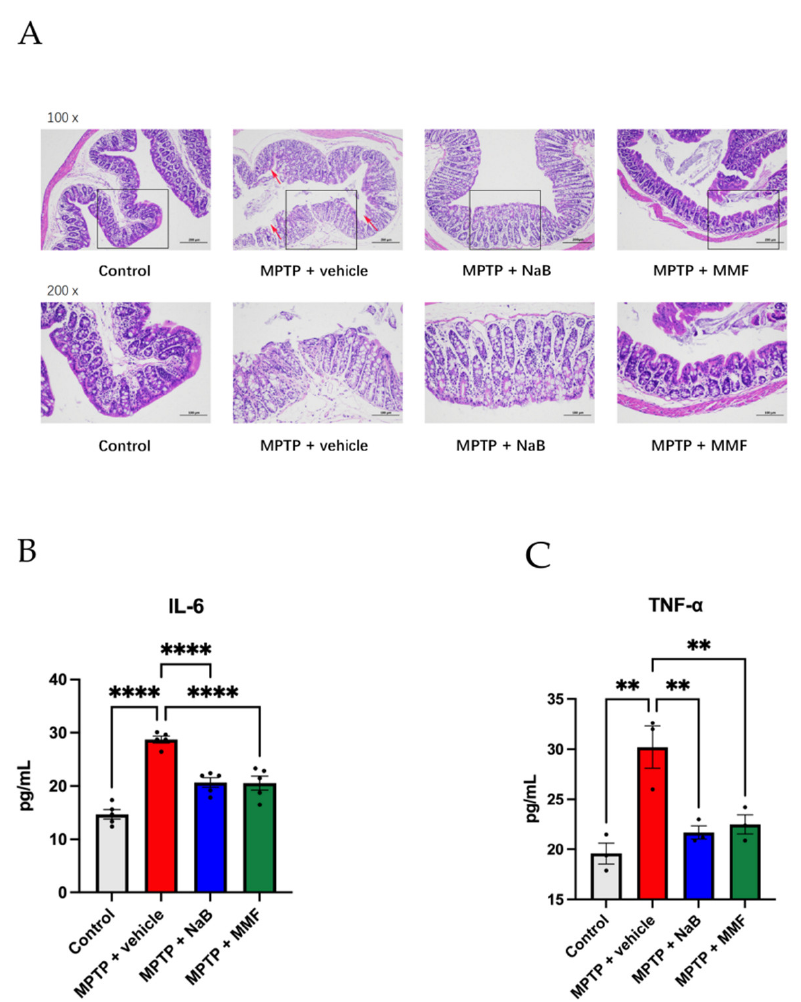
Figure 7. NaB and MMF alleviated colonic inflammation and reduced the level of IL-6 and TNF-α in the serum in PD mice. (A) HE staining of colon tissues from different groups, magnifications shown are 100 × and 200 ×; the scale bar represents 100 and 200 μm. (B) The levels of IL-6 in the MPTP + NaB group and MPTP + MMF group were significantly lower than those in the MPTP +